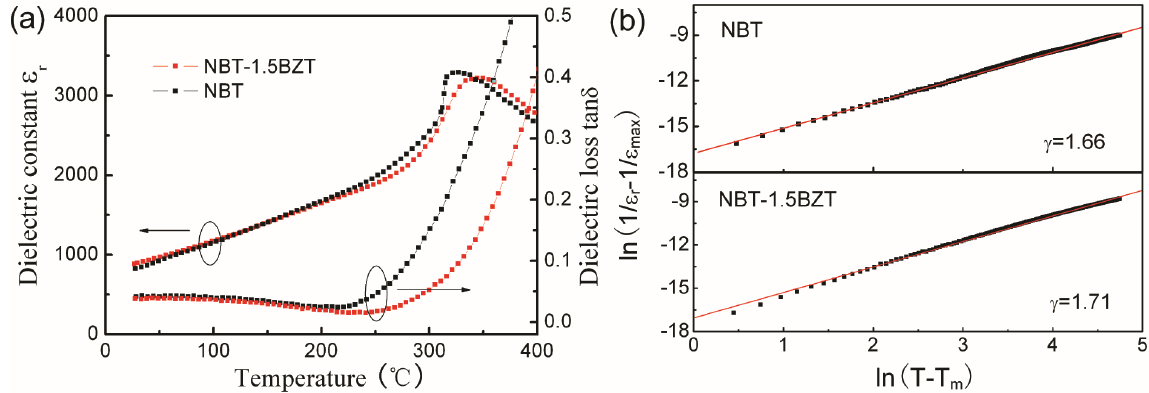
Figure 19. ( a ) Temperature and frequency dependence of dielectric constant and dielectric loss at 1 kHz; and ( b ) a plot of ln(1/ ε r – 1/ ε max ) vs . ln( T – T m ) for unpoled <001>-oriented NBT and NBT-1.5BZT crystals. Reprinted with permission from [31]. Copyright 2014